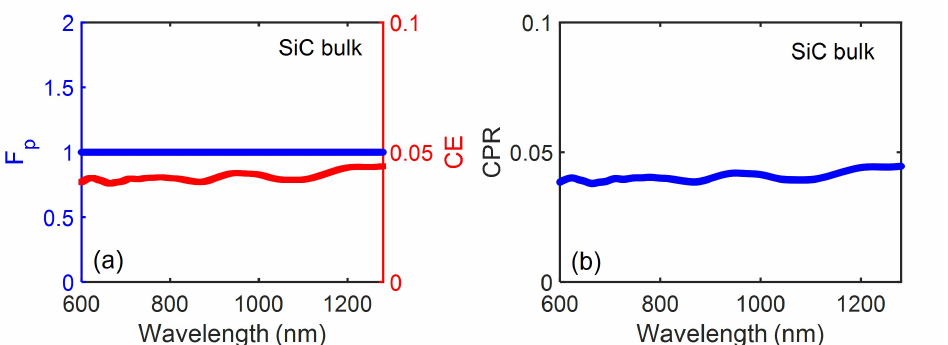
Figure 2. ( a ) The modified Purcell factor, F p and collection efficiency, CE and ( b ) the corresponding CPR performance for a point dipole emitter in bulk SiC as a function of the emission